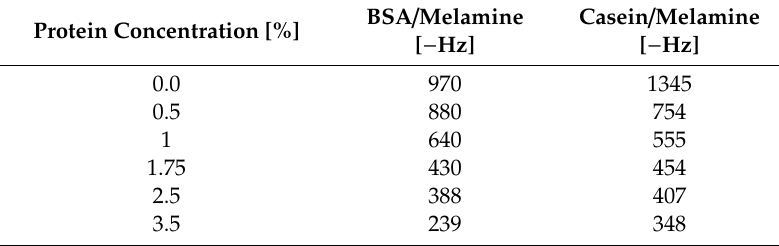
Table 2. Sensor response dependency on protein concentration at a constant melamine concentration level of 1600 mg /